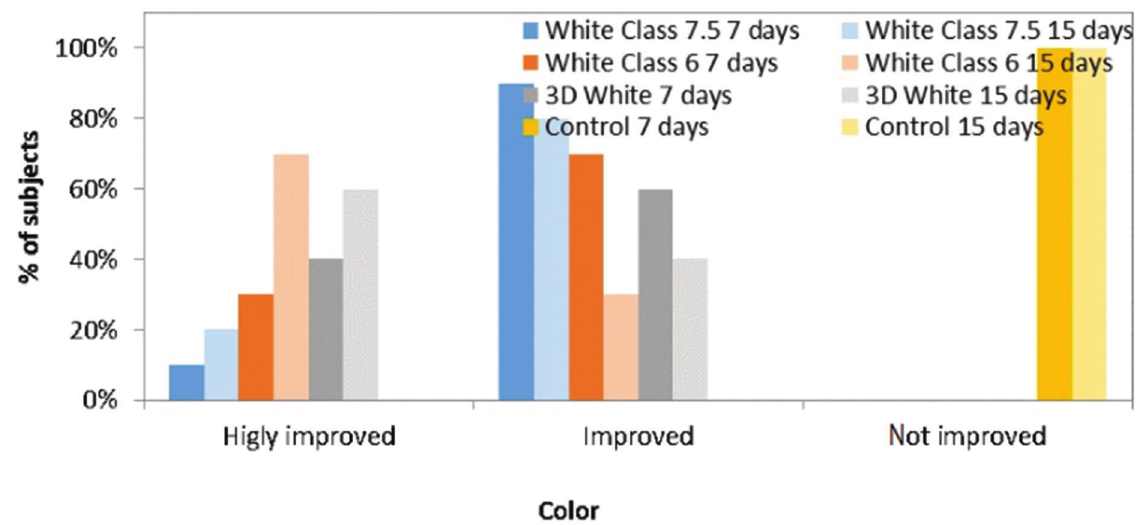
Figure 5 - Subjects ’ overall perception of